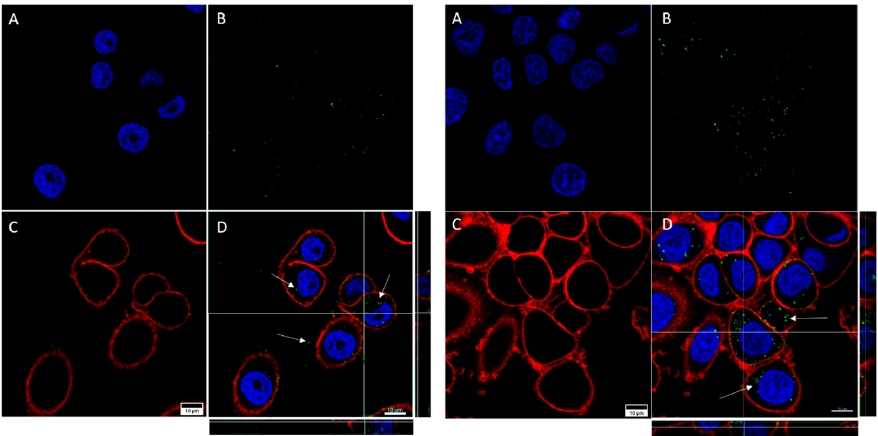
Figure 6. Confocal microscopy captures of SKBR3 cells. The images show cells treated with NF- GNPs (left) and cells treated with Tf-functionalized GNPs (right). Nuclei ( A ) are marked blue (Hoechst 33342), cytoplasmatic membranes ( C ) are marked red (CellMask™ Deep Red). Nanoparticles ( B ) are visualized as green dots due to their reflection being artificially assigned a green color by the microscope’s software. Merged images ( D ), and their orthogonal projections of the z-stack reconstructions (right and bottom), where GNPs (white arrows) can be seen.